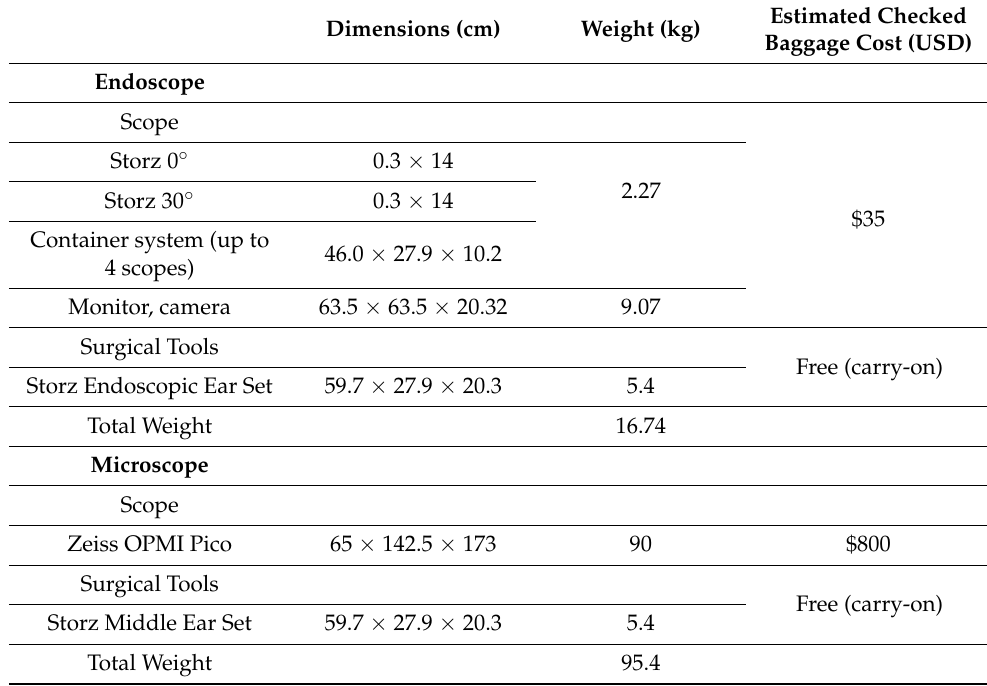
Table 2. Baggage Fees: Fees are determined based on United States airline pricing when flying internationally from the United States. The endoscopic set up will fit in one standard bag at USD 35.00 per bag. The microscope will fit into two “very” overweight bags at USD 400.00 per bag with the remaining surgical tools going in a carry-on